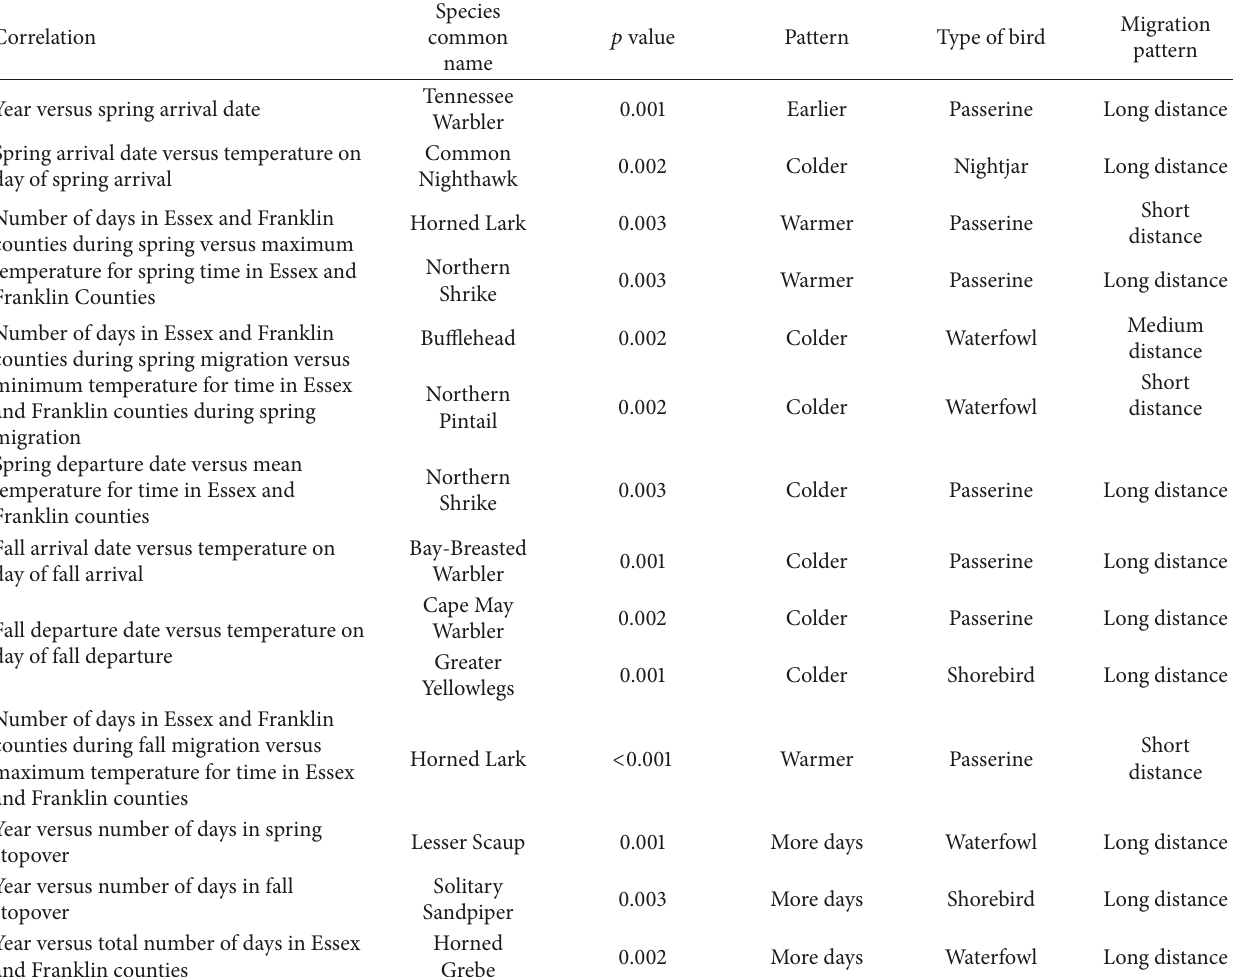
Table 4: Migration timing changes and significant environmental temperature changes experienced by species showing a two-stopover migration strategy through Essex and Franklin counties in the Adirondack region. Migration patterns were determined using data from the Cornell lab of ornithology and Zuckerberg et al.